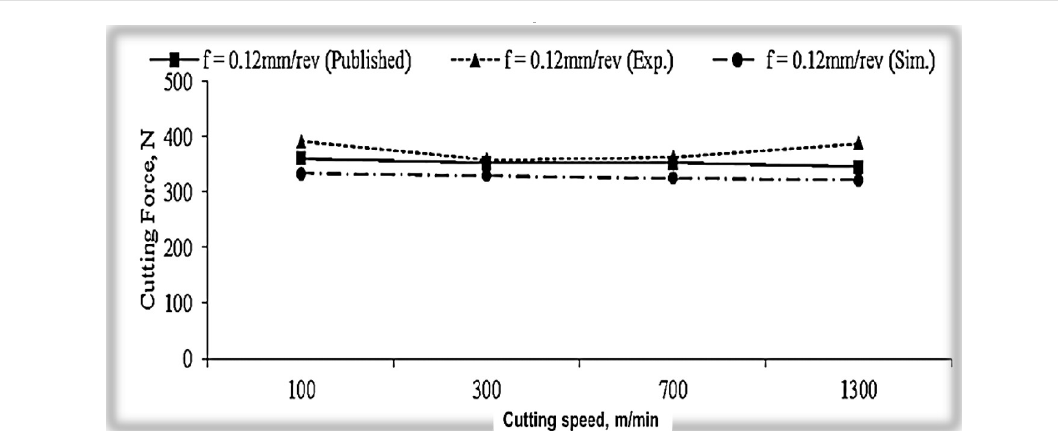
FIGURE 12. COMPARISON OF EXPERIMENTAL AND SIMULATED CUTTING FORCE, FC WITH THE PUBLISHED RESULTS AT THE FEED RATE, F =